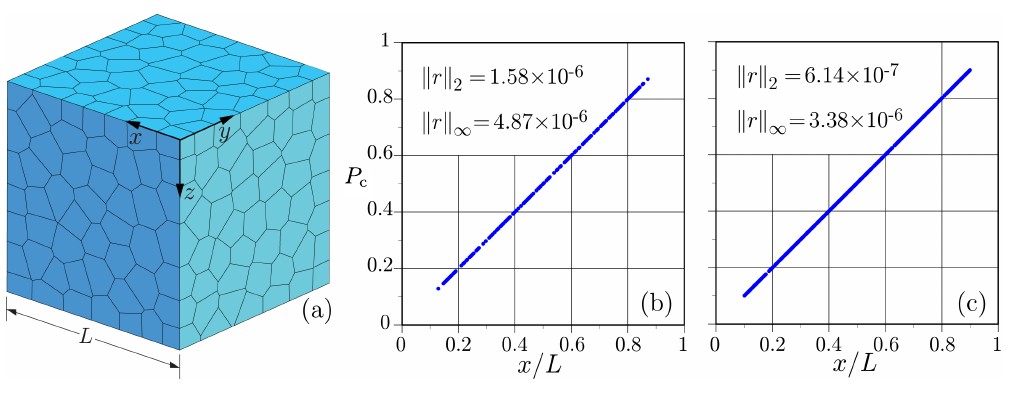
Figure 5. Steady-state simulation of potential flow: ( a ) Voronoi tessellation of domain; ( b ) conventional network solution; and ( c ) proposed network